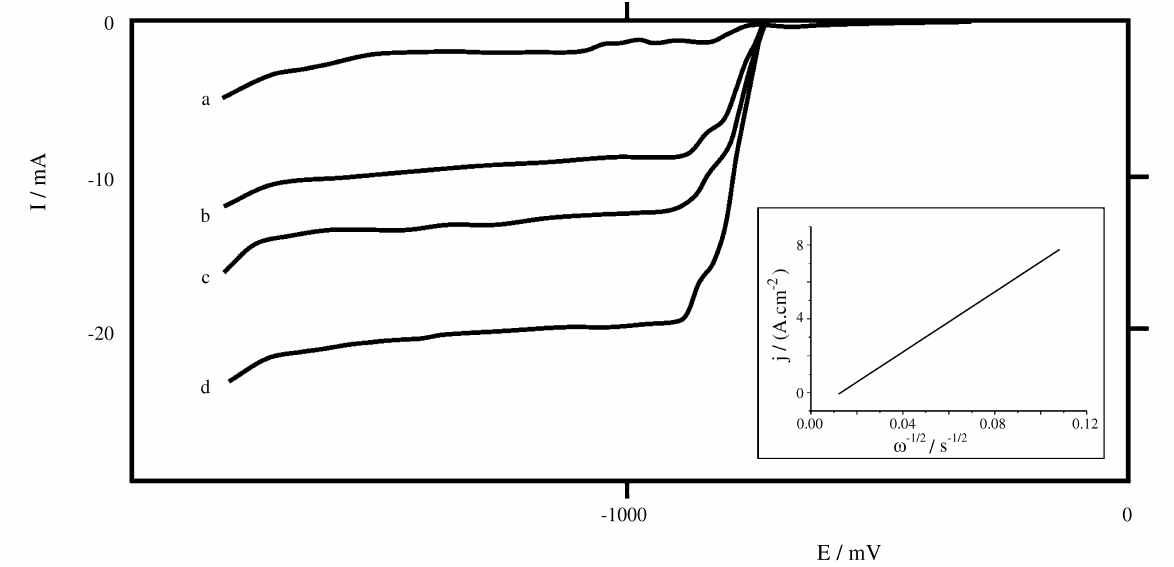
Figure 2. Linear voltammetric curves for Cd 2+ reduction at a glassy carbon rotating disc electrode. Aerated 10 mg L -1 Cd 2+ ion in pH 4.8 sulfuric-sulfate solution. Potentialscansfrom Esa = 0.00 V to Esc = -1.80 Vat0.02 Vs -1 and rotation speed of (a) 100; (b) 1000;(c) 1500 and (d)2500 rpm. Inset: j lim-1 vs. ω -1/2